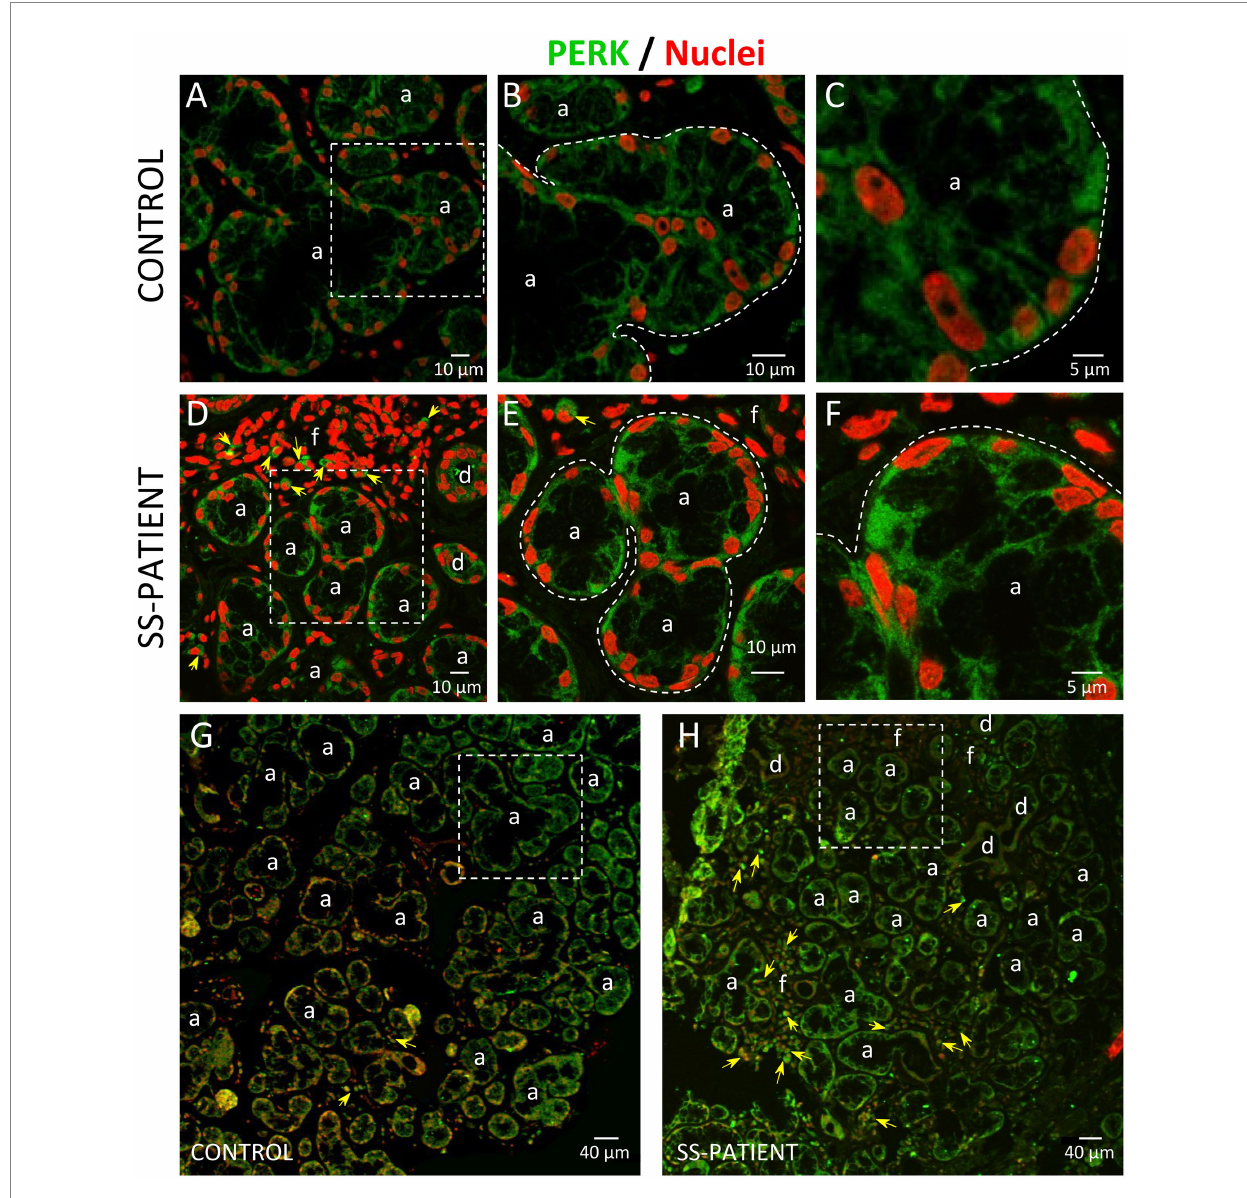
FIGURE 6 Localization of PERK in LSGs from control and SS-patients. (A–C,G) PERK (green) staining was mainly observed in the basolateral cytoplasm of epithelial cells in LSG from control subjects. (D–F,H) PERK (green) staining was also observed in the basolateral cytoplasm of epithelial cells and few plasma cells (yellow arrows) in LSGs from SS-patients. (A,D) Higher magnifications of regions surrounded by broken lines in G and H, respectively. (B,C,E,F) Higher magnifications of regions surrounded by broken lines in A and B, respectively. Nuclei (red) were counterstained with Hoechst-33342. a: acini; d: duct; f: focus of inflammatory cells. Bars A, B, D and E: 10 μ m; C and F: 5 μ m; G and H: 40 μ